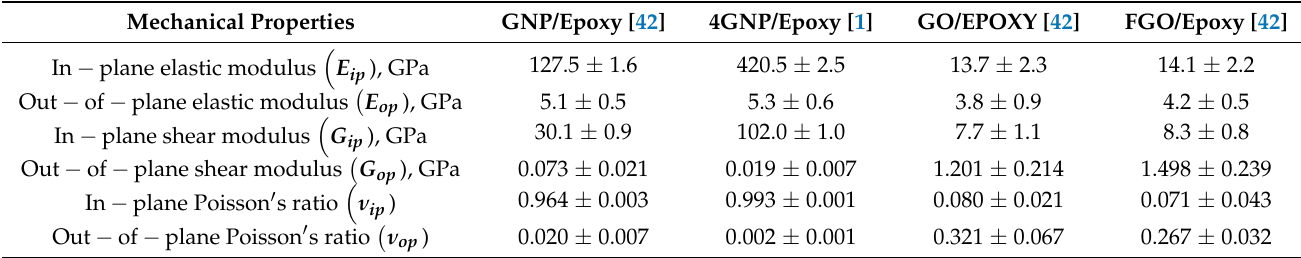
Table 1. The predicted elastic properties of graphene nanoplatelet/epoxy nanocomposite MD models (effective mechanical properties of the locale interphase region).